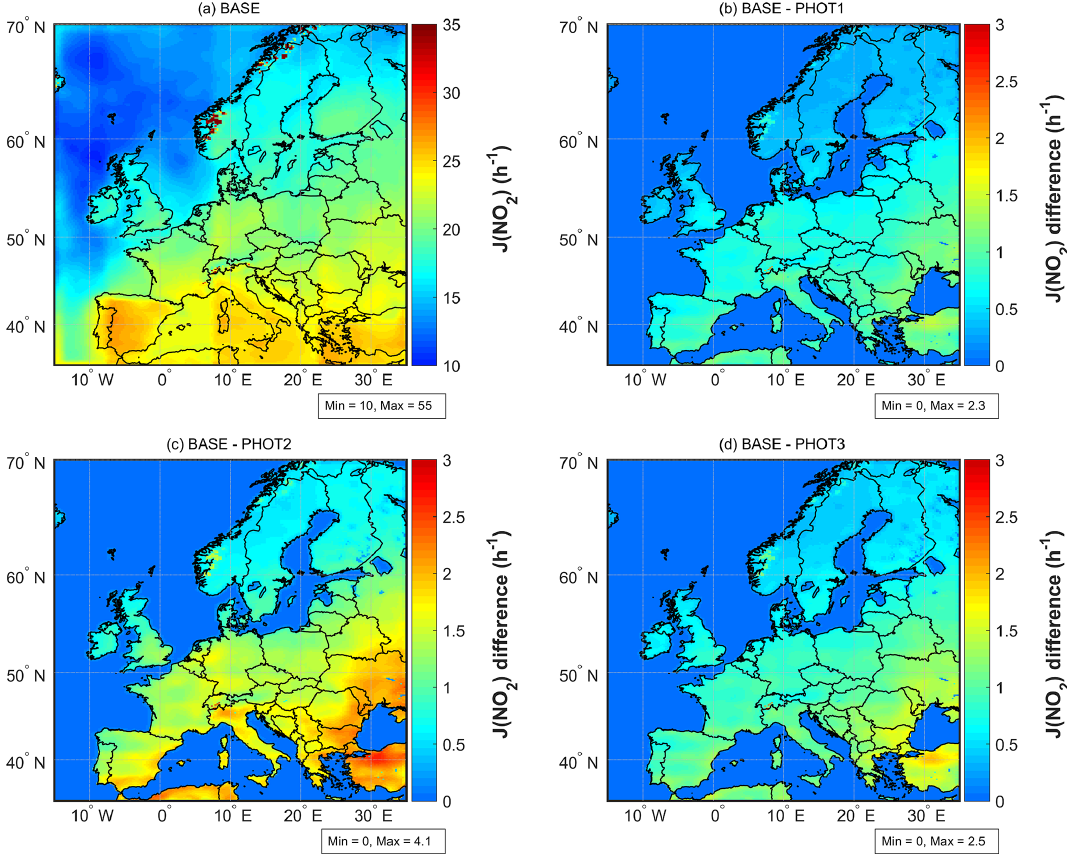
Figure 6. Seasonal daytime (10:00 − 18:00LMT) mean J (NO 2 ) at ground level for the BASE scenario (a) and J (NO 2 ) differences between the BASE scenario and the PHOT1, PHOT2 and PHOT3 scenarios (b–d) , respectively, in summer 2010. Note the different color scale between panel (a) and panels (b–d)